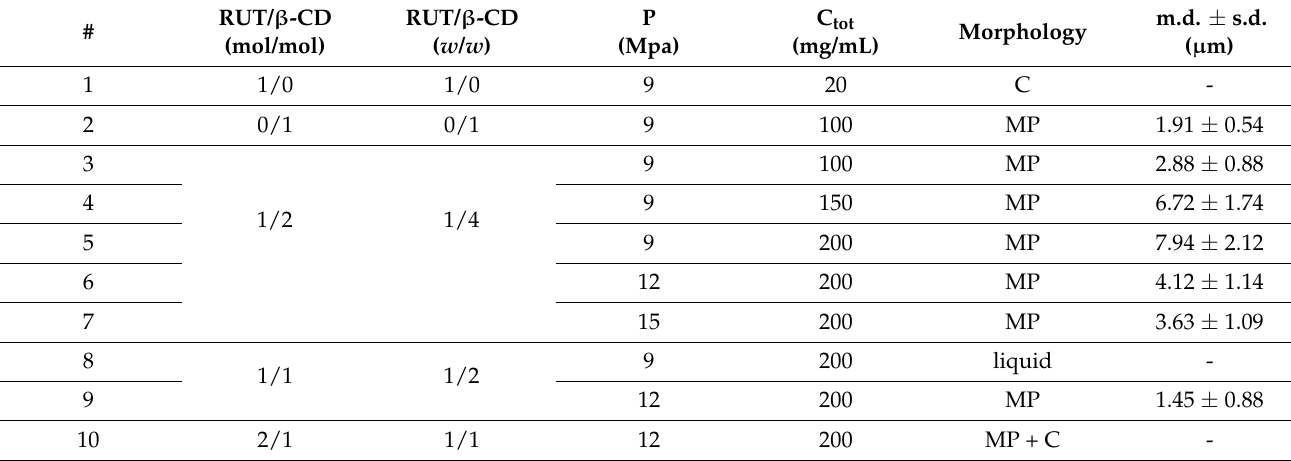
Table 1. A summary of SAS experiments performed (P = pressure; C tot = total concentration of solutes in DMSO; MP = microparticles; C =